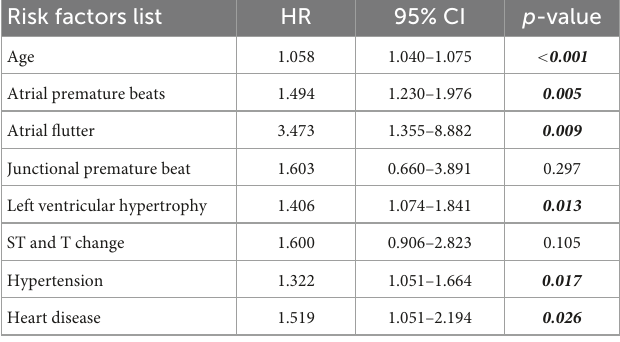
TABLE 10 Combined predictors for subjects with and without AF (cox proportional hazard model, multivariate